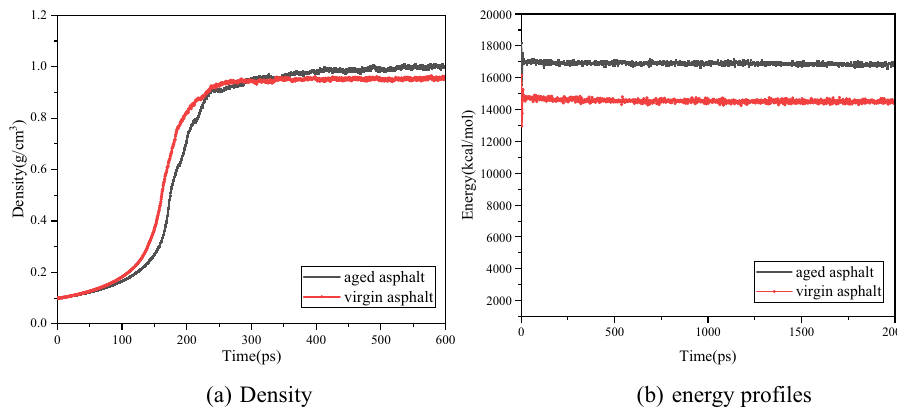
Figure 2. Simulation equilibrium: (a) density, and (b) energy profiles.